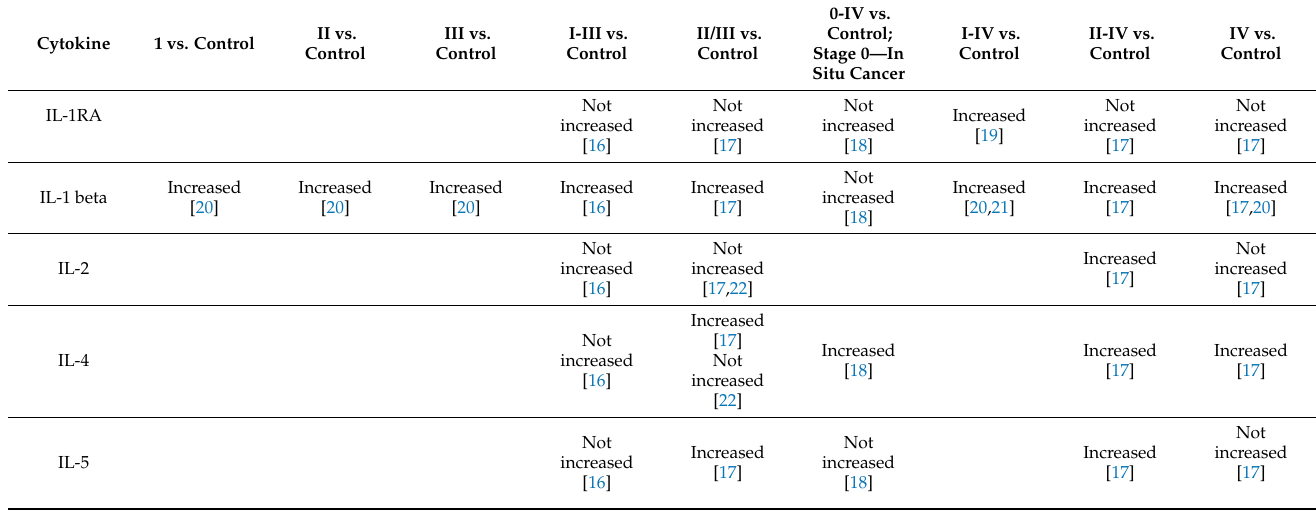
Cytokine 1 vs. Control